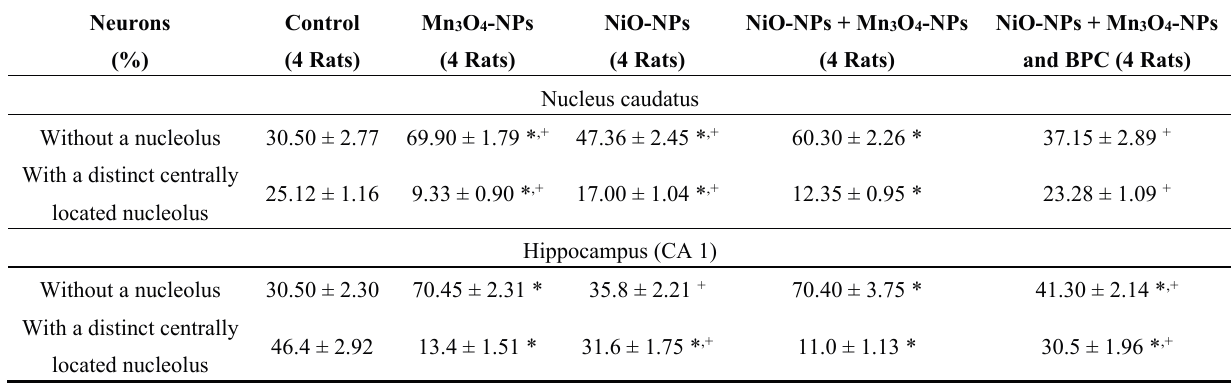
Table 6. Morphometric indices for the state of the rat’s brain after repeated intraperitoneal injections of NiO or Mn 3 O 4 nanoparticles, together or separately, and of their combination with background oral administration of the BPC (X ±